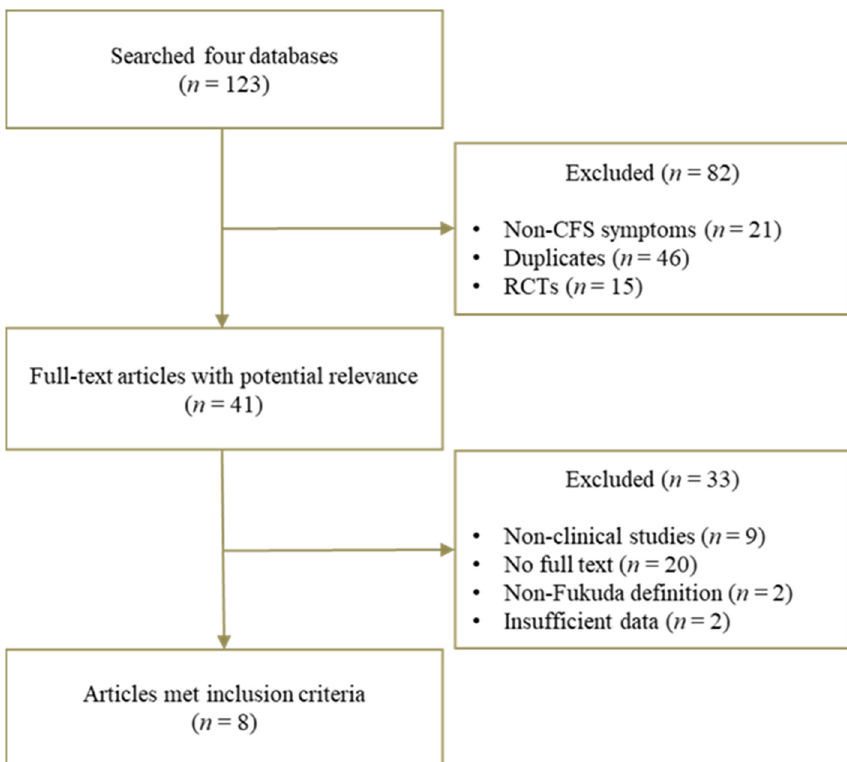
Figure 1. Flow chart for selection of articles.